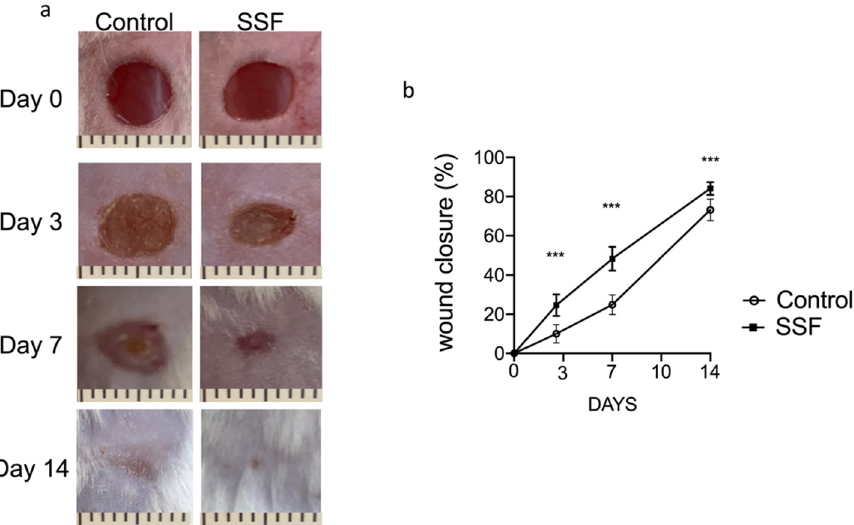
Figure 1. Effect of snail secretion filtrate (SSF) on the rate of wound healing in a mouse model of full-thickness excisional wounds. ( a ) Representative picture of wounds at the different time point (scale bar 1 mm). ( b ) The graph shows the results expressed as the percentage of original Wound size over time. Data are presented as means ± SEM images of 10 mice for each group. *** p < 0.001 versus control.